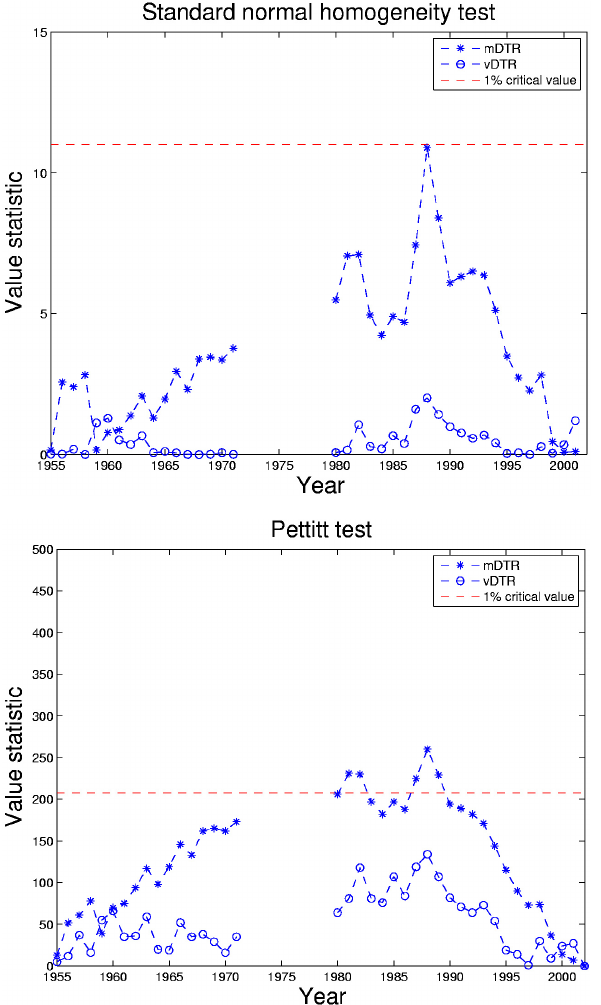
Figure 3. Results of the standard normal homogeneity test and Pettitt test applied to the 3 rural subseries (1955–2002, see Table 1).